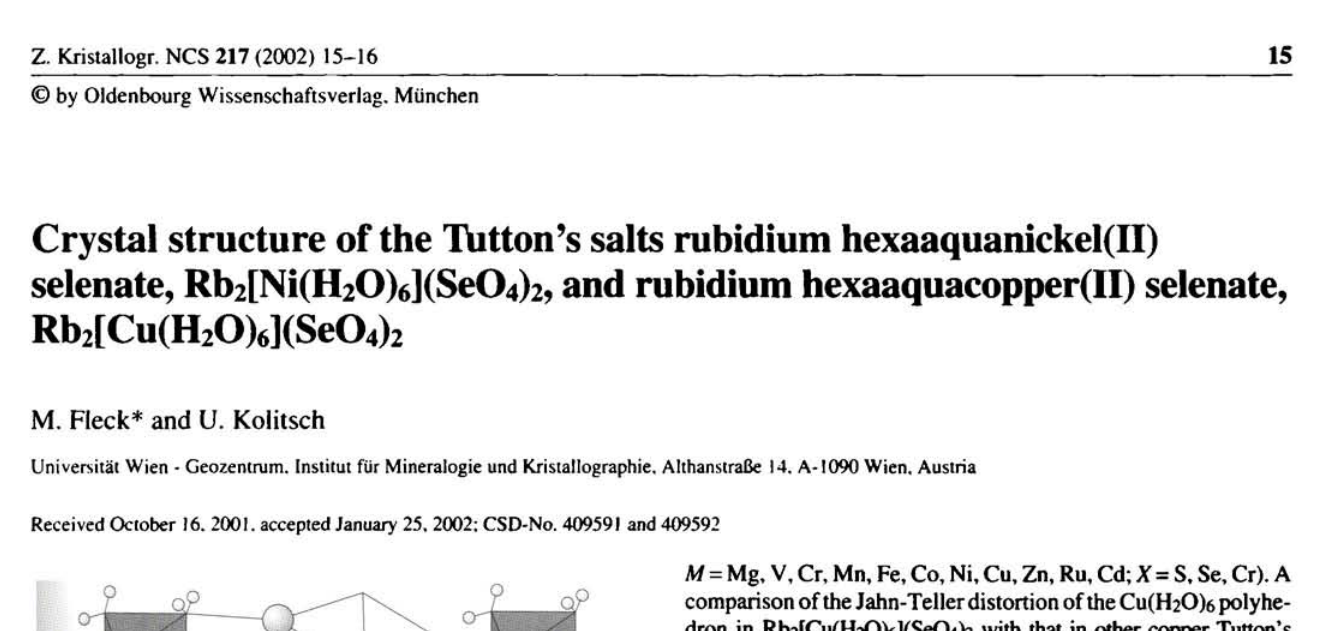
Table 1. Data collection and handling. Crystal: